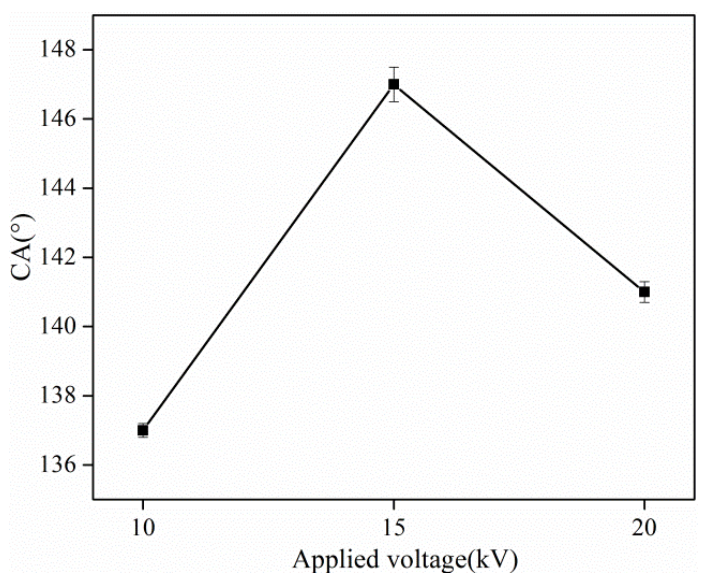
Figure 9. Contact angle of electrospun PS nanofibrous mats with different applied voltages.